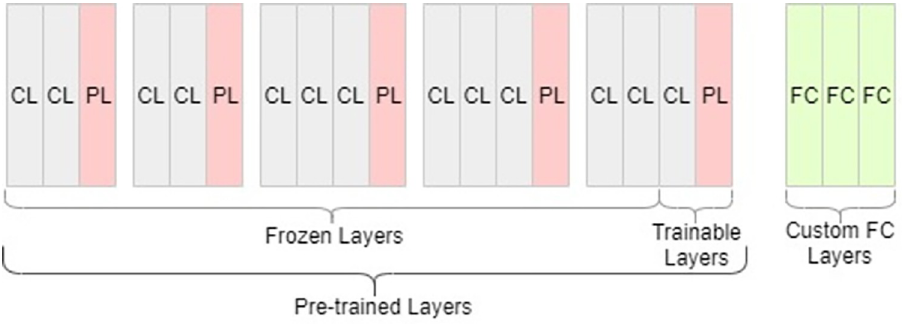
Fig 3. Pre-trained VGG16 model used for transfer